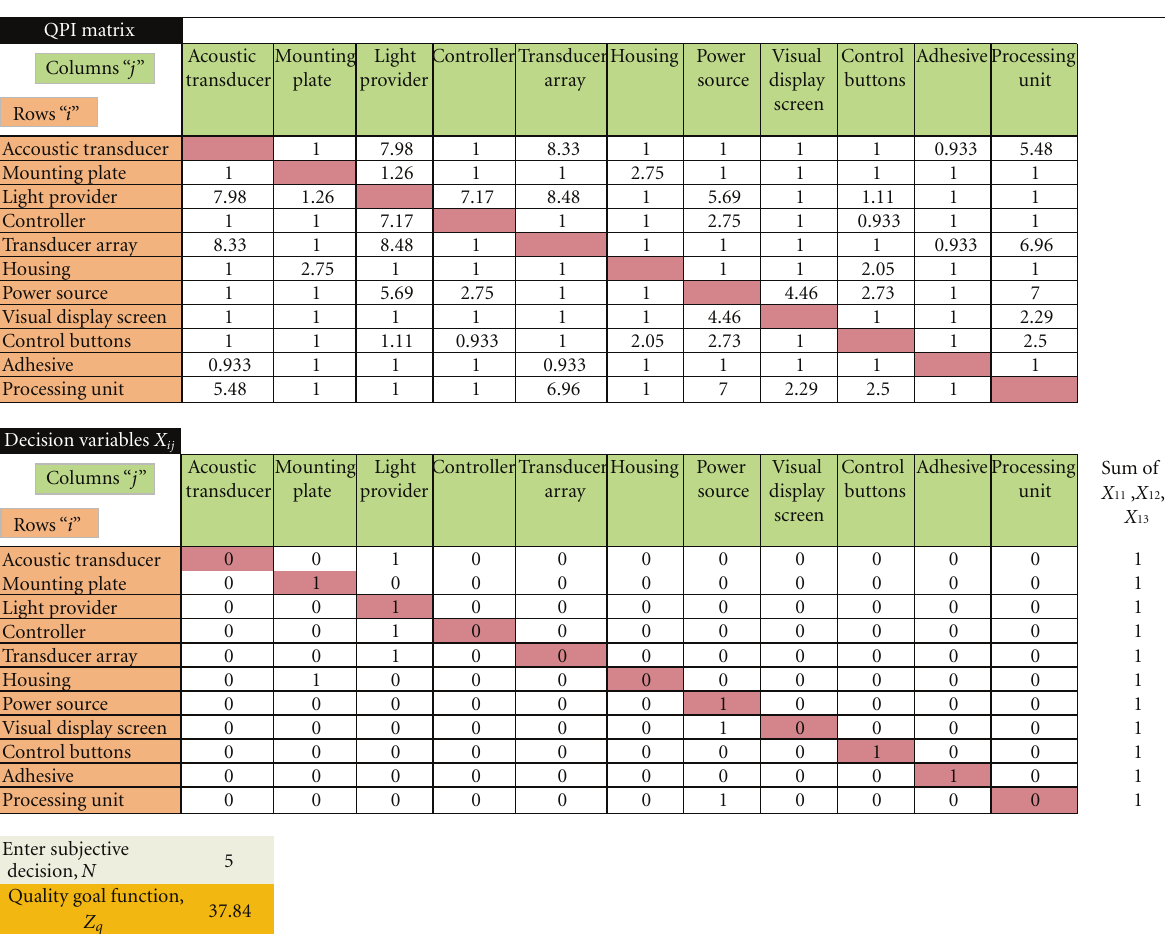
Control AdhesiveProcessing buttons screen